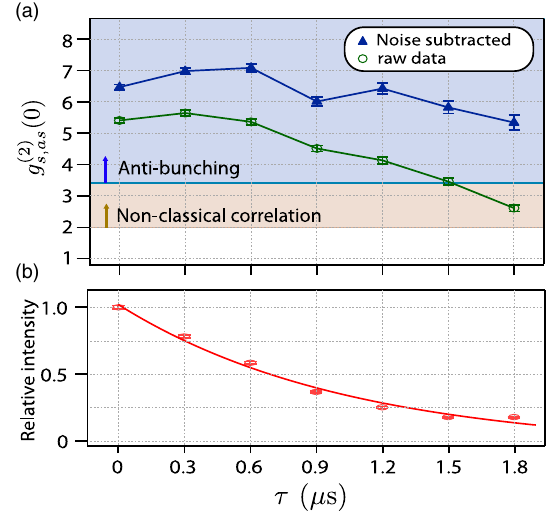
FIG. 4. Nonclassical nature of the single-photon SLP. (a) The ð 2 Þ ð 0 Þ between Stokes and anti-Stokes second-order correlation g s;as photons as a function of the single-photon trapping time τ . The raw ð 2 Þ ð 0 Þ was calculated without subtracting any noise counts. g s;as Unwanted noise counts due to unfiltered strong read lasers were independently measured and subtracted for the calculation of the ð 2 Þ ð 0 Þ . The bound for nonclassical correlation, noise-subtracted g s;as ð 2 Þ ð 0 Þ ¼ 2 , calculated from the Cauchy-Schwarz inequality, is g s;as and the bound for antibunching of the heralded anti-Stokes photon ffiffiffi p ð 2 Þ ð 0 Þ ¼ 2 þ 2 is g . (b) The relative intensity of the anti-Stokes s;as photon as a function of τ . The SLP decay rate of γ τ ¼ 2 π × 154 kHz was obtained from the exponential decay fit (solid